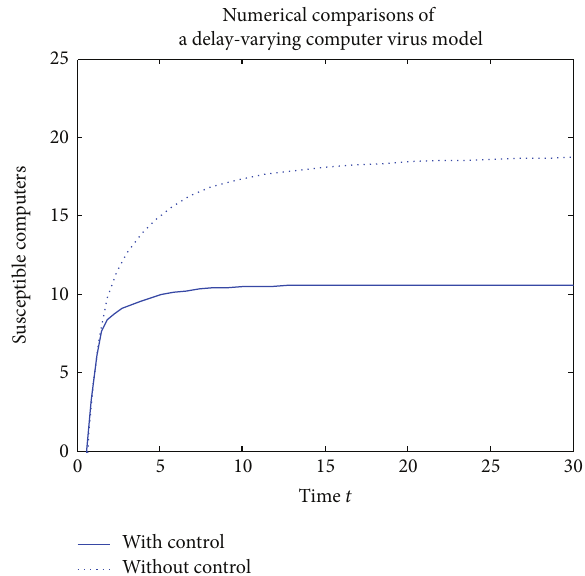
Figure 1: Susceptible computers (with and without control) versus time 𝑡 .